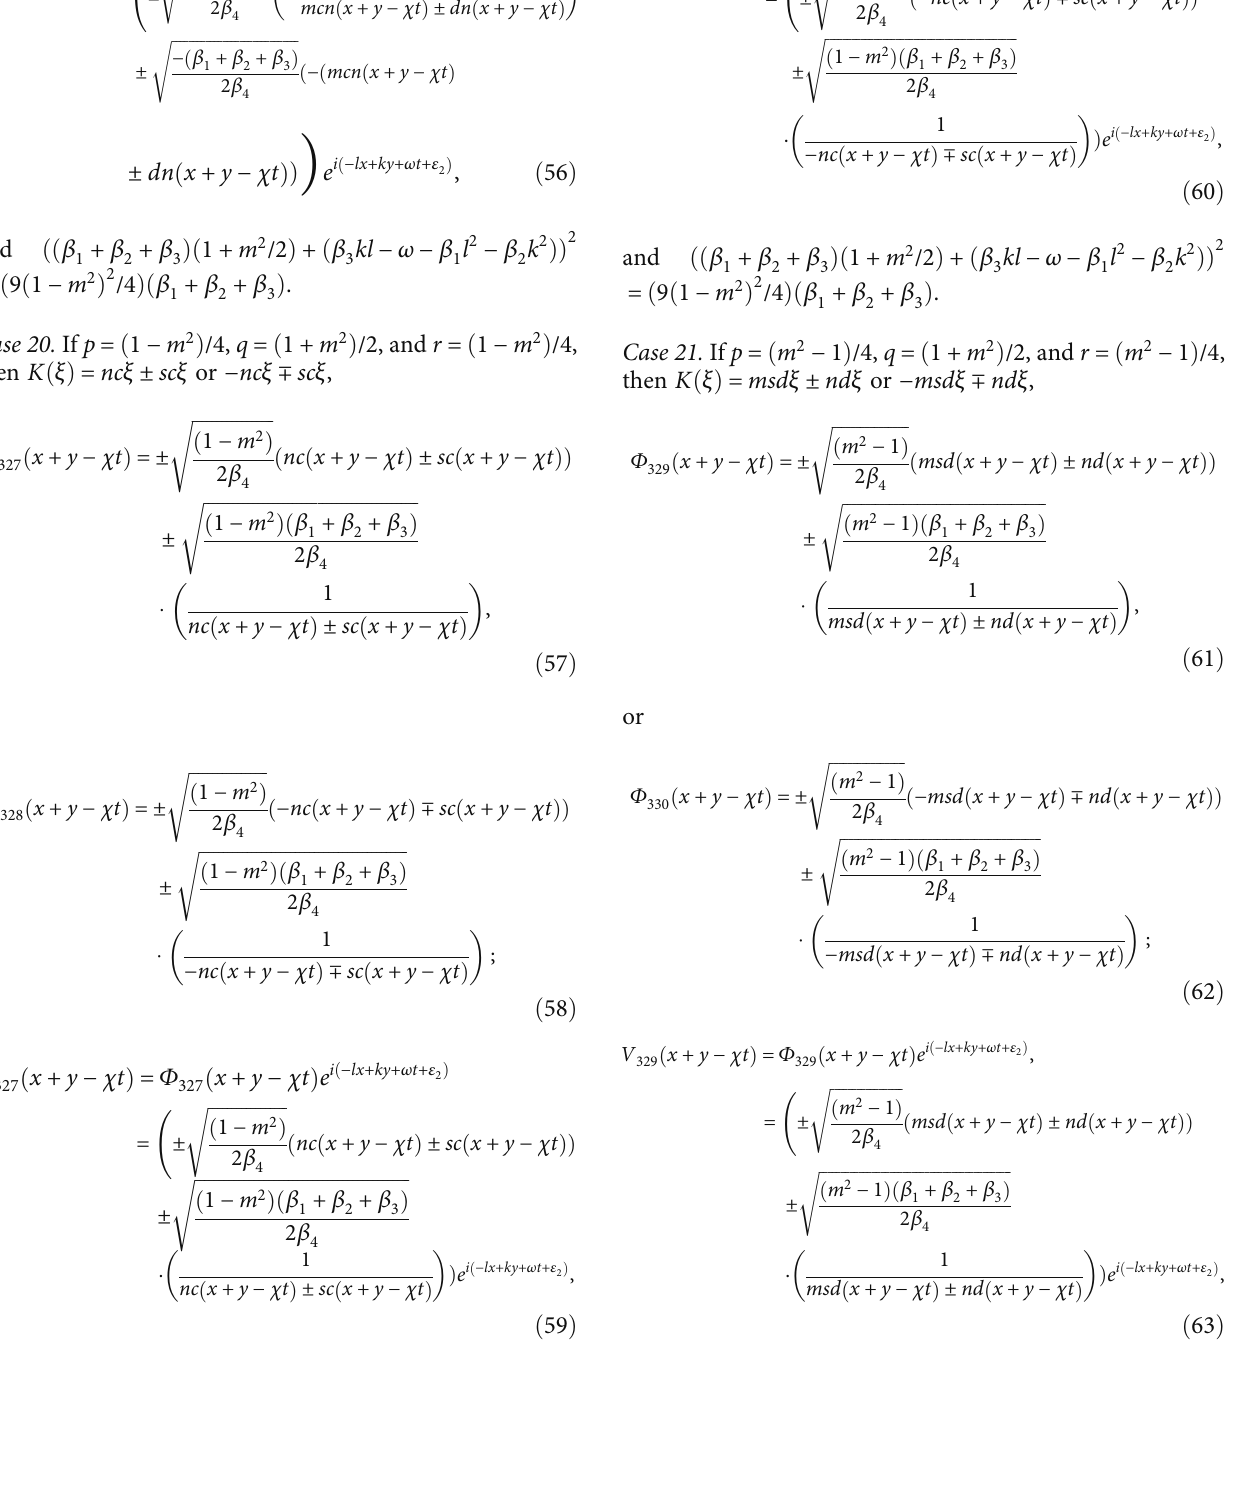
ffiffiffiffiffiffiffiffiffiffiffiffiffiffiffiffiffi 1 − m 2